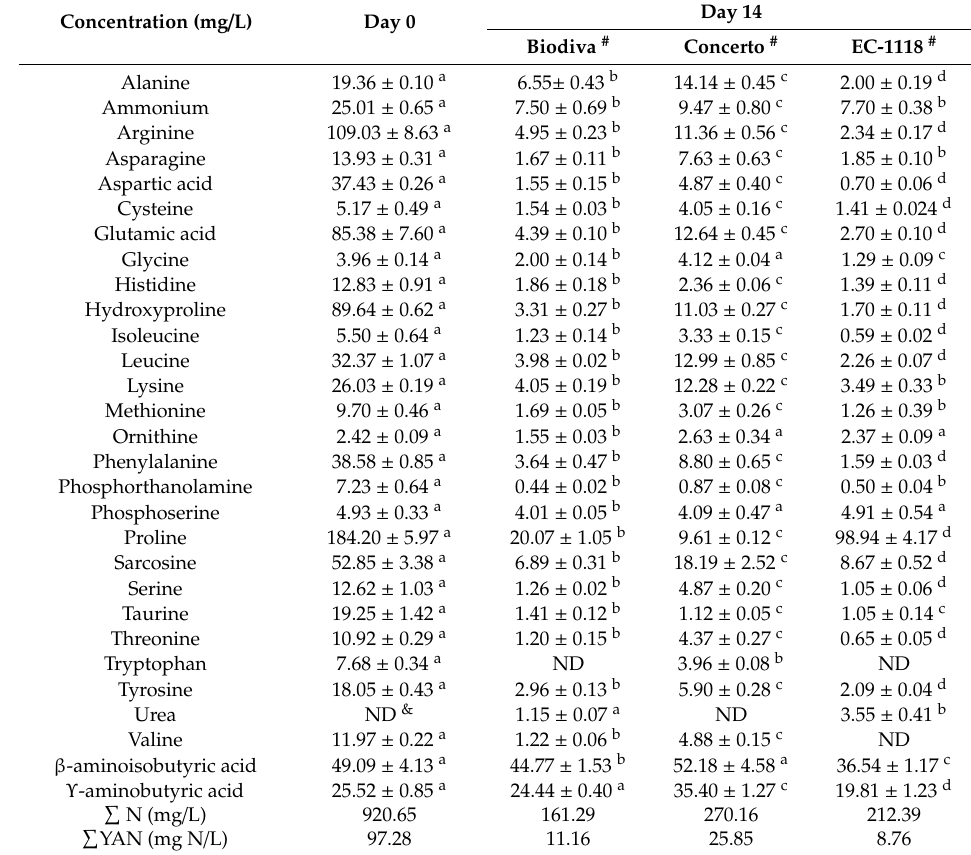
Table 2. Amino compounds in red dragon fruit juice and wines fermented with Saccharomyces and non- Saccharomyces yeast